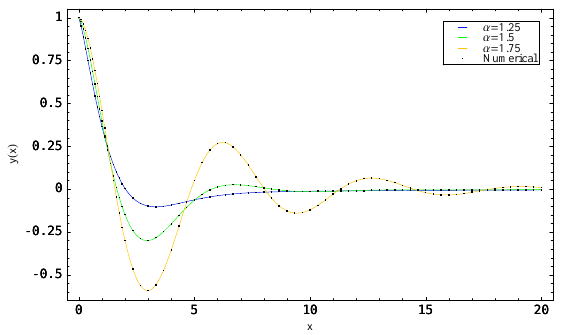
Fig. 2: Comparison of y ( x ) for h = 1 , N = 30 and 0 < α ≤ 1 with exact solutions for Example 1. Points are discrete approximations